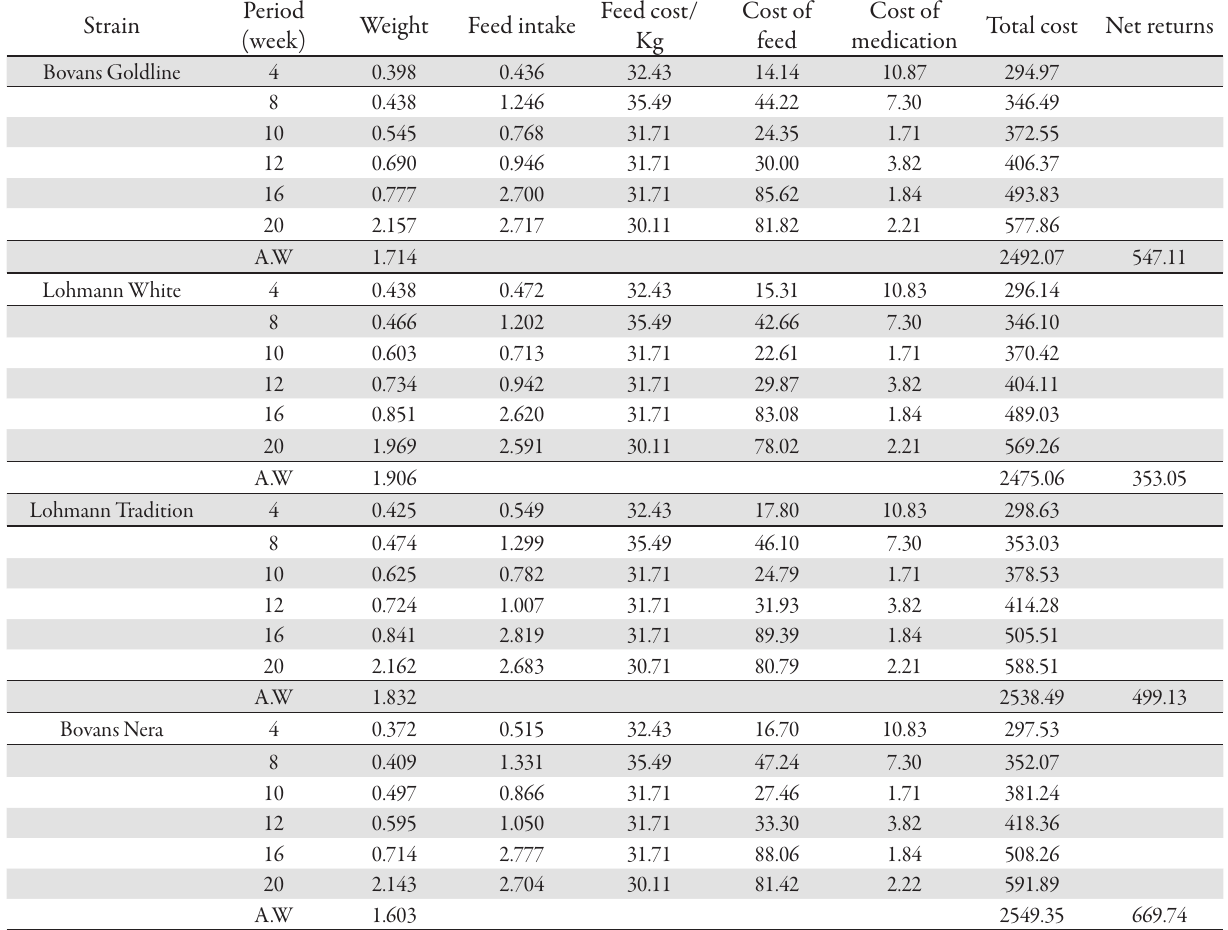
Tab. 5. Profitability analysis of the strains of